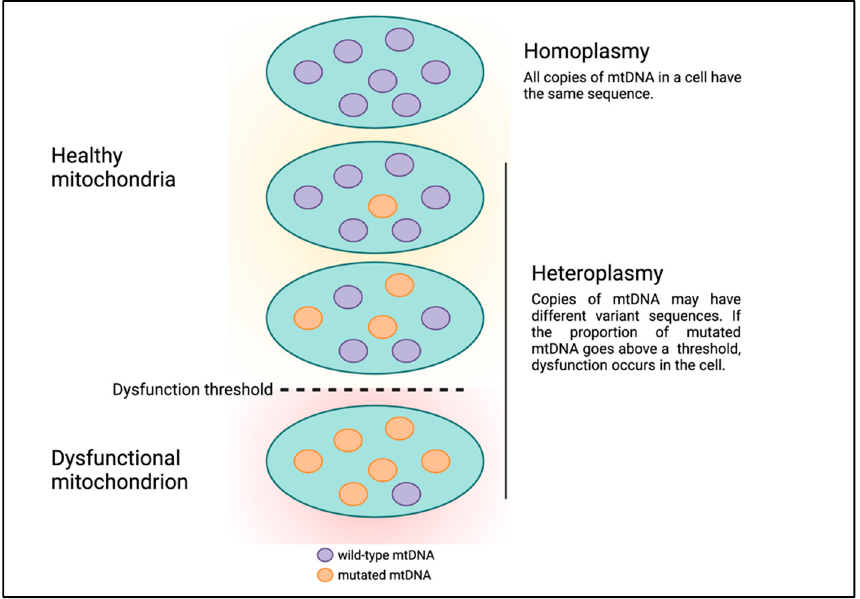
Figure 1. Heteroplasmy and the threshold